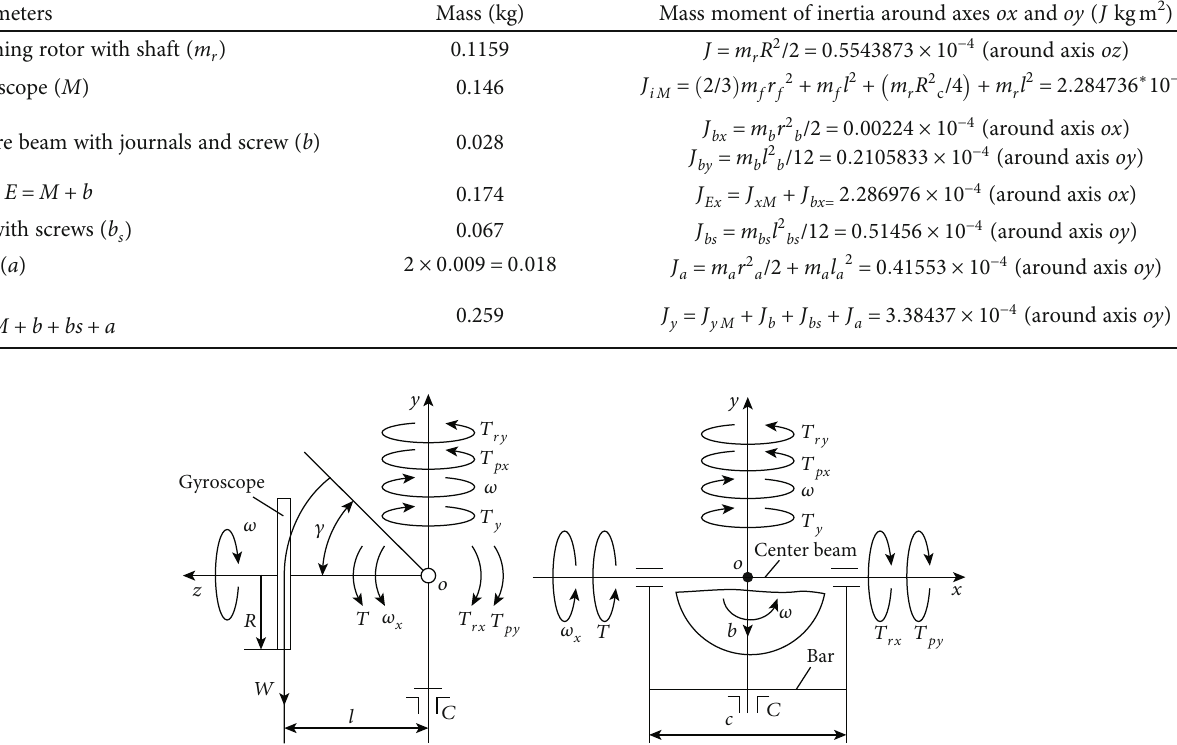
Figure 2: Internal torques and motions when the load torque T